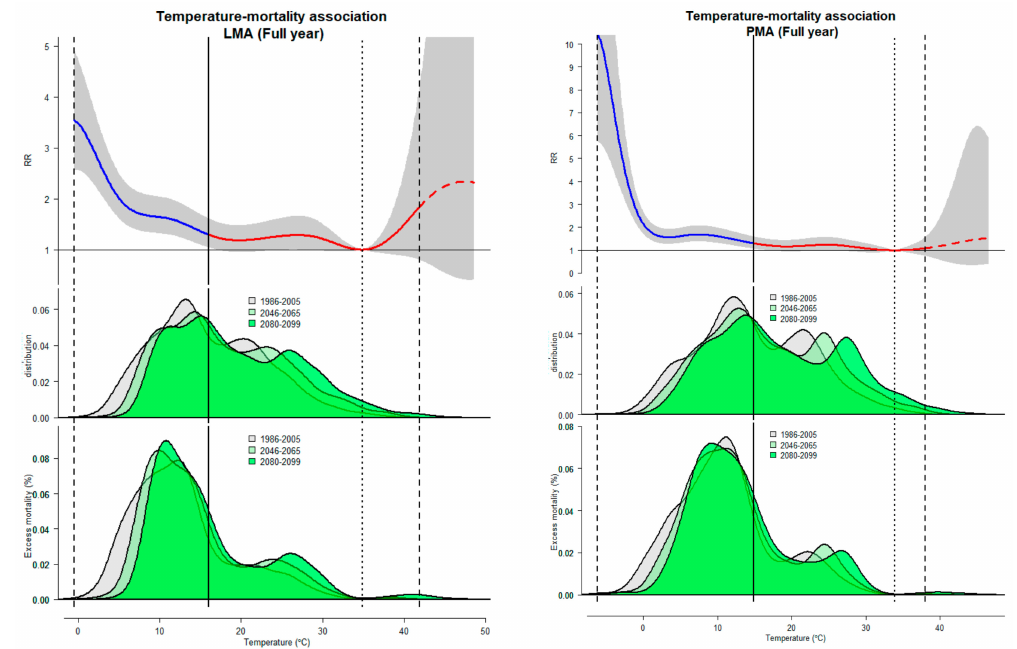
Figure 5. Temperature and excess mortality for the historical and future periods in the study region. Top panel: Exposure–response curve for temperature–mortality relative risk (RR), with the blue and red lines representing cold and hot, respectively, together with their 95% CI in grey. The solid vertical line corresponds to the mean temperature that divides the curve into cold and hot, while the dotted represents the reference temperature (MMT). The dashed red line represents the extrapolation beyond the maximum temperature in 1986–2005 (broken vertical line) for the future periods. Middle panel: Temperature distribution for the historical (grey area) and future periods, 2046–2065 (green area) and 2080–2099 (darker green area). Bottom panel: Temperature-related excess mortality distribution expressed as the fraction of additional deaths (%) attributed to non-optimal temperature, compared with the reference